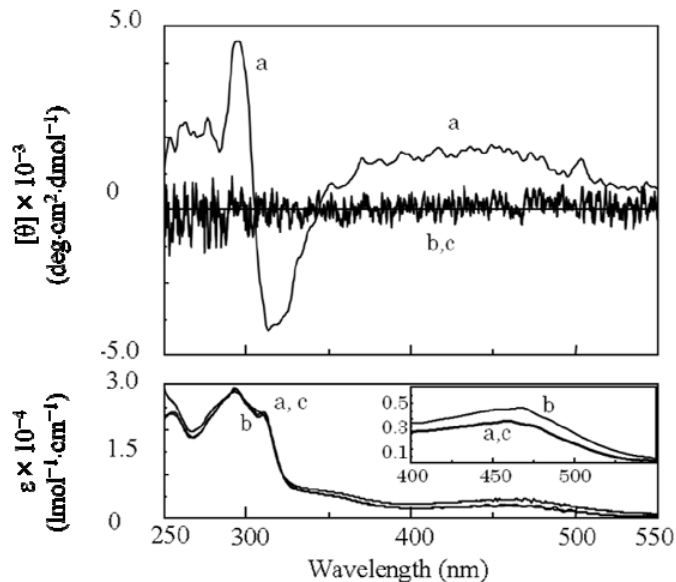
Figure 9. CD and UV-Vis spectra of poly( re -1 ) in (a) THF, (b) THF/DMSO = 80/20(v/v) and (c) THF/DMSO = 99/1 (v/v) ((c) was the solution prepared by addition of THF to the solution of